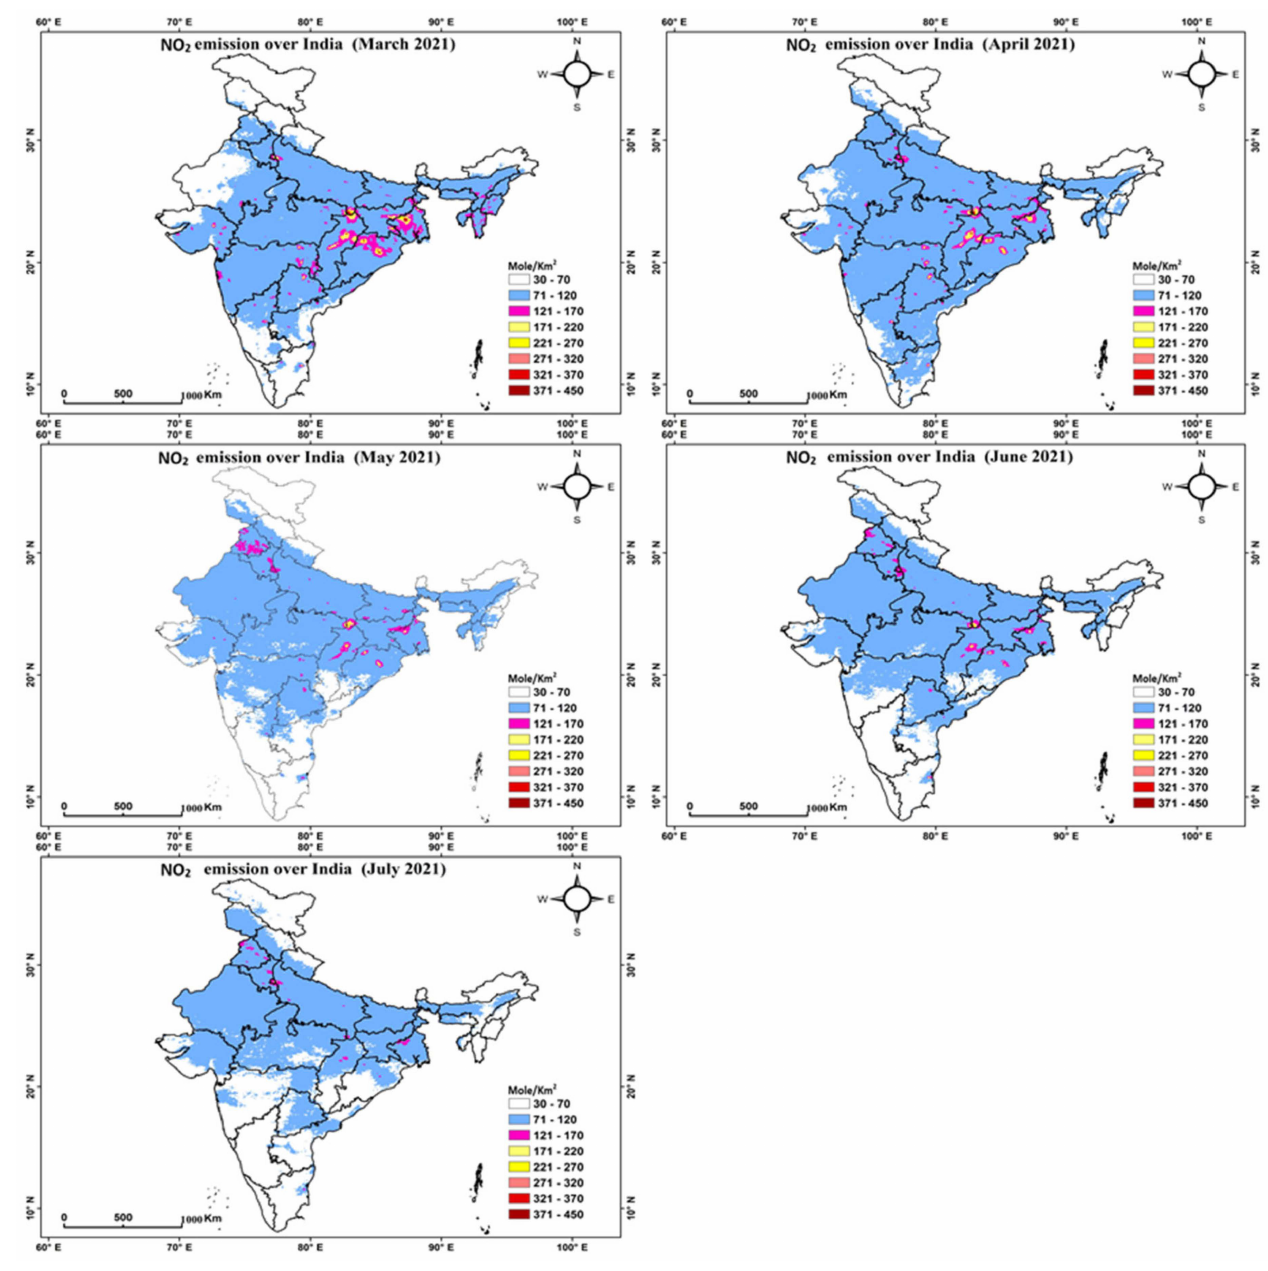
Figure 3. NO 2 emissions over India as observed by Sentinel-5P during wave 2 from March to July 2021. Table 4. Comparison of changes in NO 2 concentration over eight North Indian cities during COVID- 19-induced lockdown in 2020 (March–July) with regard to 2019 and